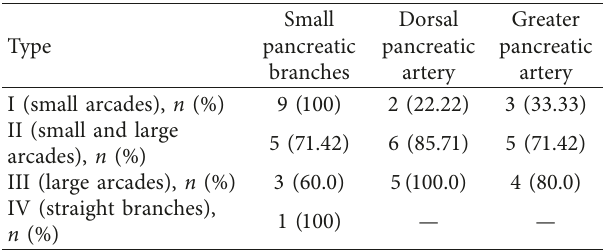
Table 2: Arteries that participated in the formation of vascular